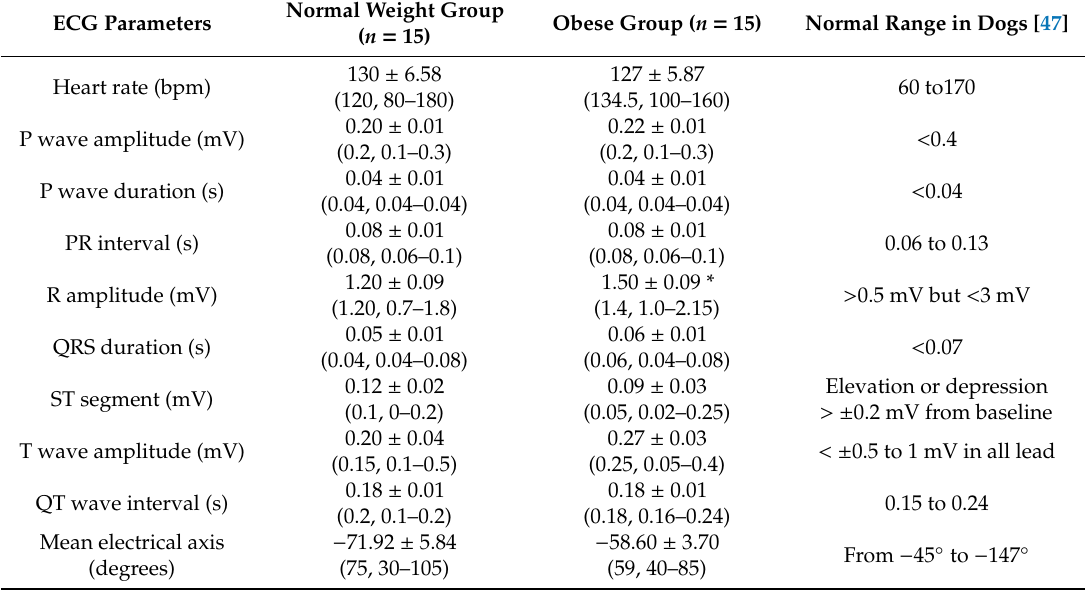
Table9. ECGparametersinnormalweightandobesegroups. Mean ± SE(median, minimum–maximum) are